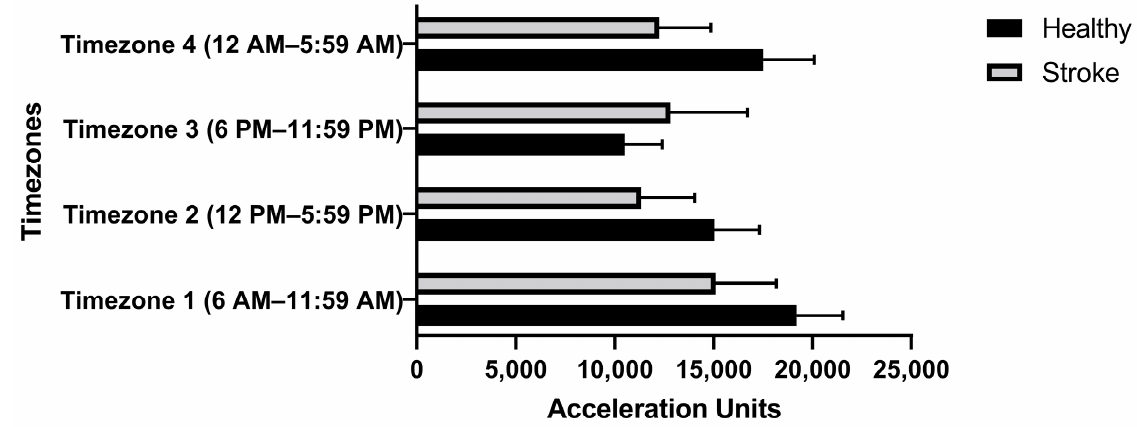
Figure 9. Time-zone-wise distribution of activity amplitude among stroke and healthy participants.